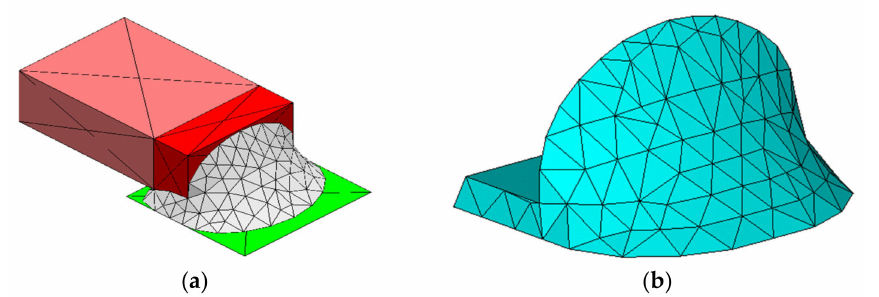
Figure 5. SMT solder joint geometry model based on minimum energy. ( a ) Solder joint geometry modeling evolved in surface evolver; ( b ) reconstructed in